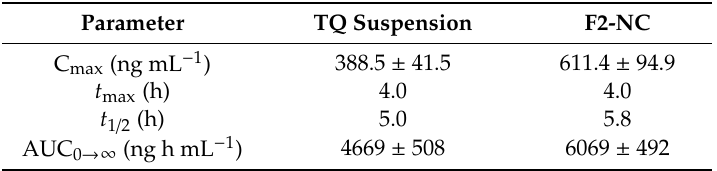
Results are presented as mean ± SD ( n =